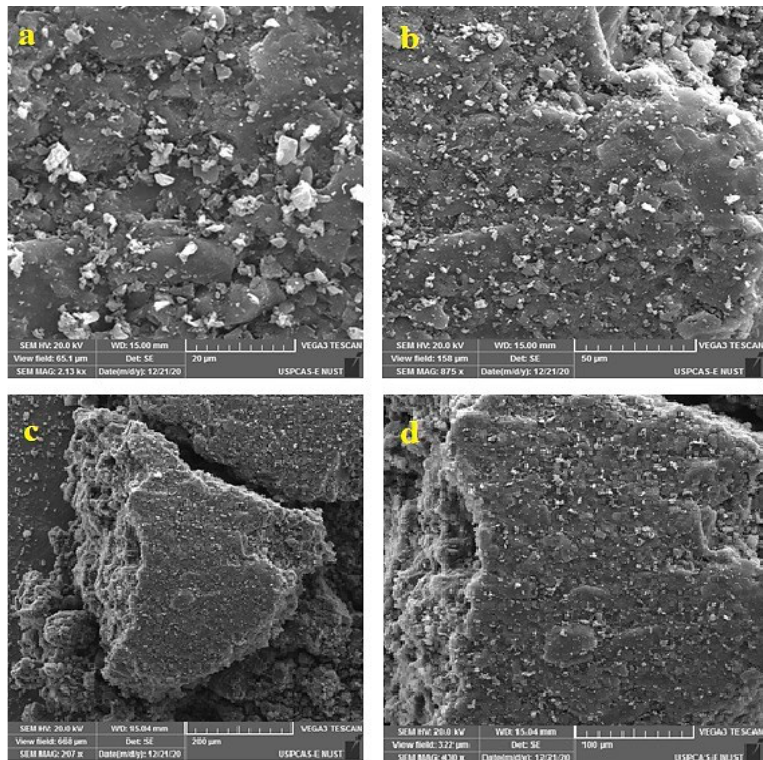
Figure 5. SEM micrographs of ( a , b ) Pure AC and ( c , d ) mAC.